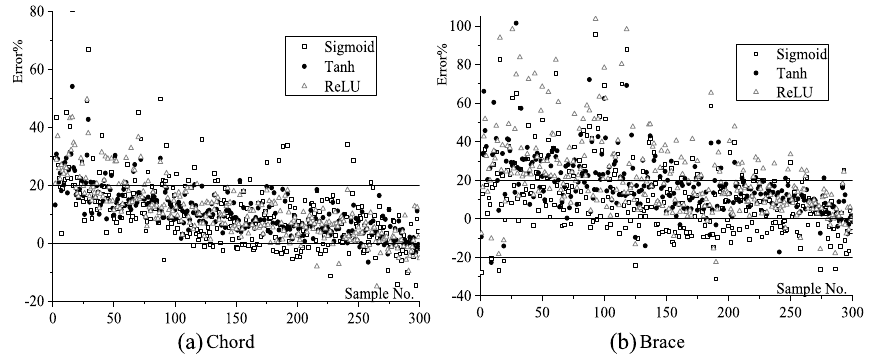
Fig. 13 Error distribution from BPNN prediction